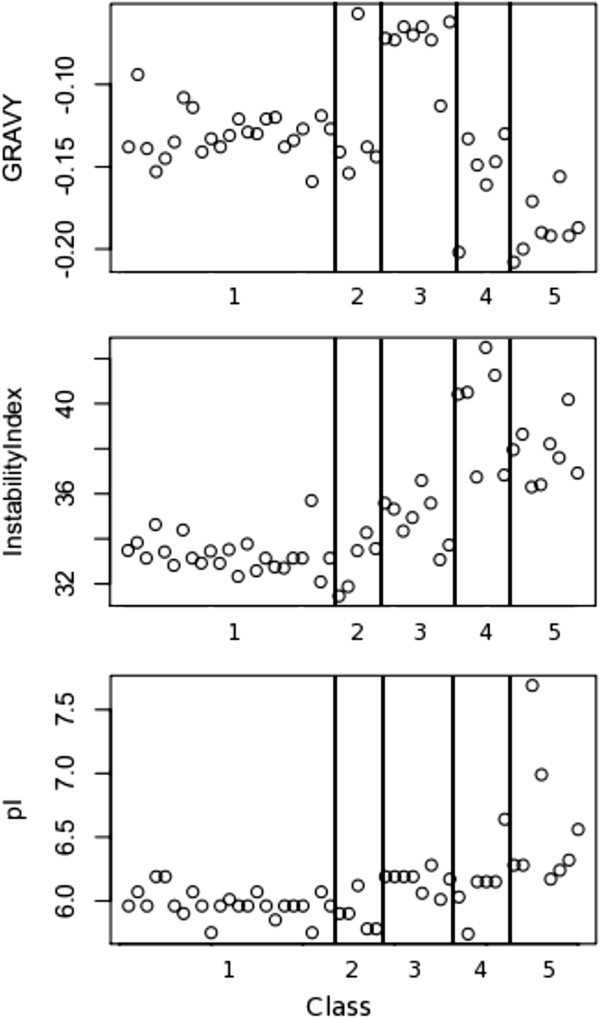
Variation in indices of predicted protein biochemistry among all alpha tubulin copies, arranged by class. Top = grand average of hydropathy (GRAVY), middle = Instability Index, bottom = isoelectric point (pI).